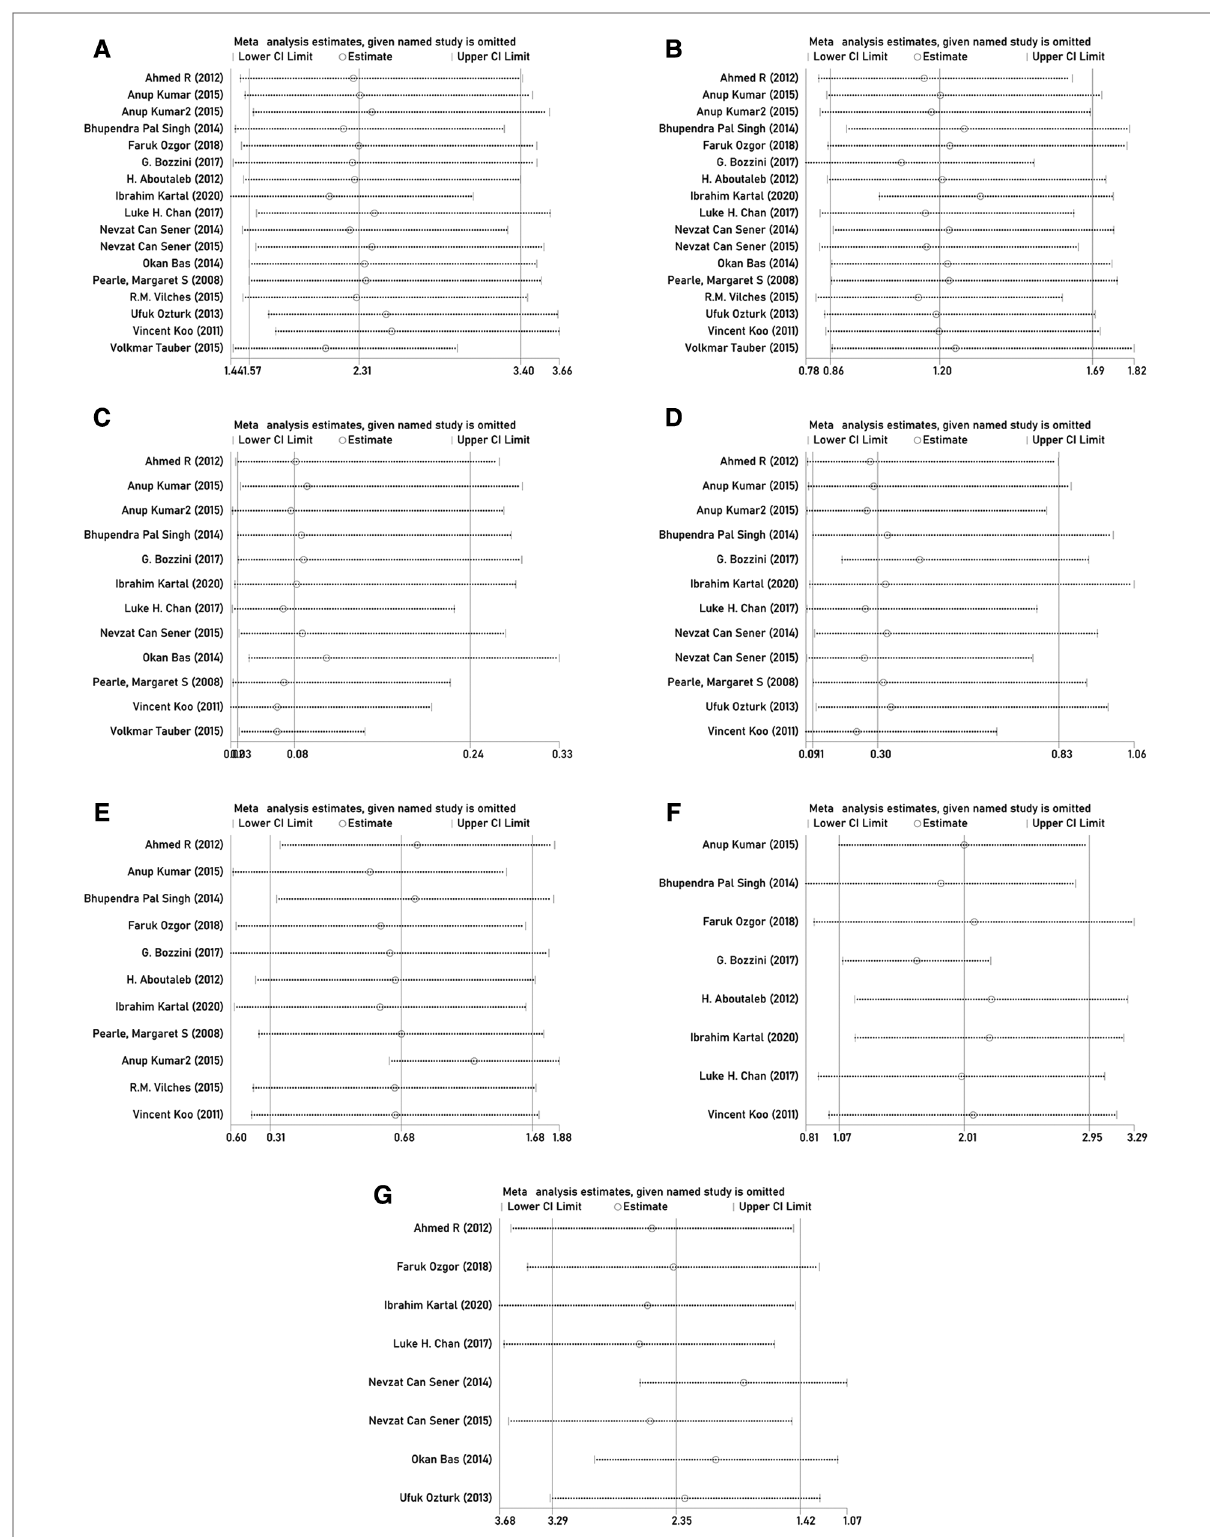
FIGURE 12 Sensitivity analysis of ( A ) stone-free rate; ( B ) complication rate; ( C ) retreatment rate; ( D ) auxiliary procedure rate; ( E ) operation time; ( F ) hospital stay; and ( G ) number of